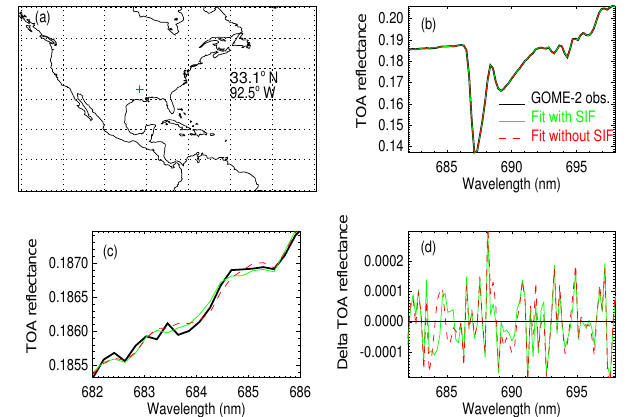
Figure 7. Similar to Fig. 4 for actual GOME-2 radiance residuals (RMS) for pixels with moderate to high amounts of green vegetation (NDVI > 0.5) for a single day (1 July